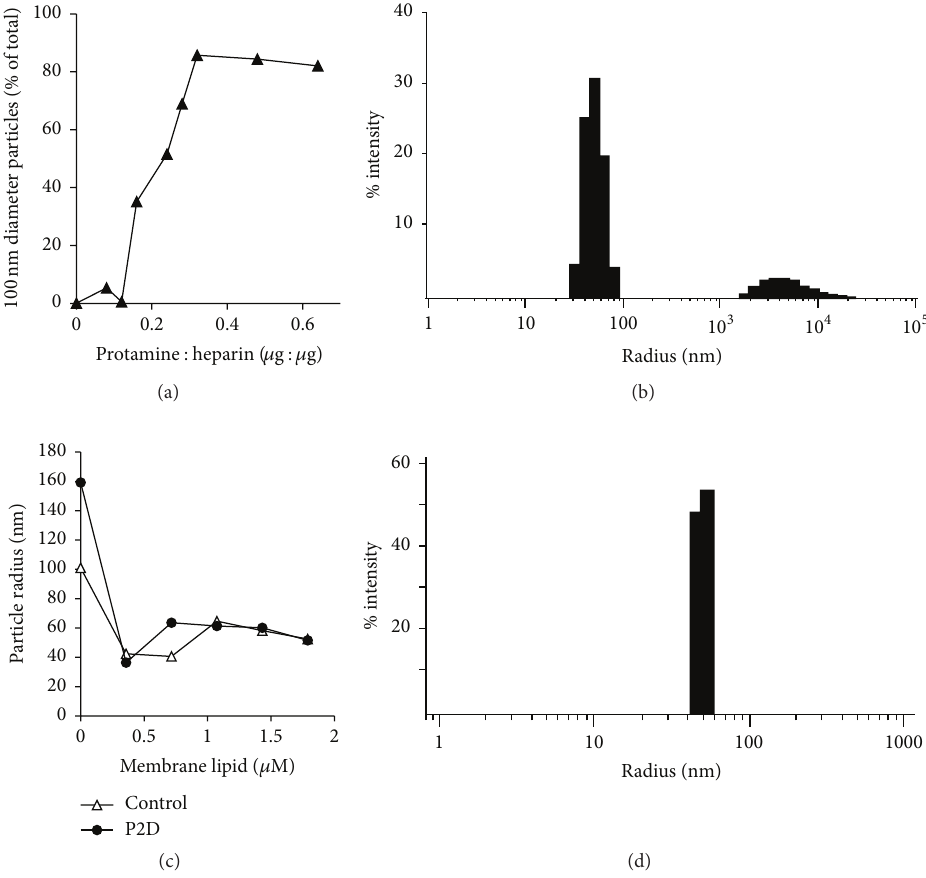
Figure 1: Construction of nanoparticles. (a) Titration of heparin-peptide complex with protamine. Protamine samples (60 𝜇 L) containing 15 𝜇 g heparin and 200 nM peptide in PBS were tested for the particle hydrodynamic radius by dynamic light scattering (DLS). The proportion of particles with a radius of ∼ 100nm is plotted. (b) Representative DLS profile; peptide-heparin-protamine core. Representative DLS profile of particles containing 0.3: 1 protamine:heparin (w:w) together with 200 𝜇 M P2 (KYCCSRK). (c) Titration of core complex with membrane lipids. Core particles were prepared as in (b), and increasing amounts of membrane particles (Section 2) were added prior to measurement of hydrodynamic radius by DLS. P2D P2 peptide built of D-amino acids. (d) Representative DLS profile, fully assembled nanoparticles. Representative DLS profile of particles with core structures prepared as in (b), after addition of 0.4mM membrane